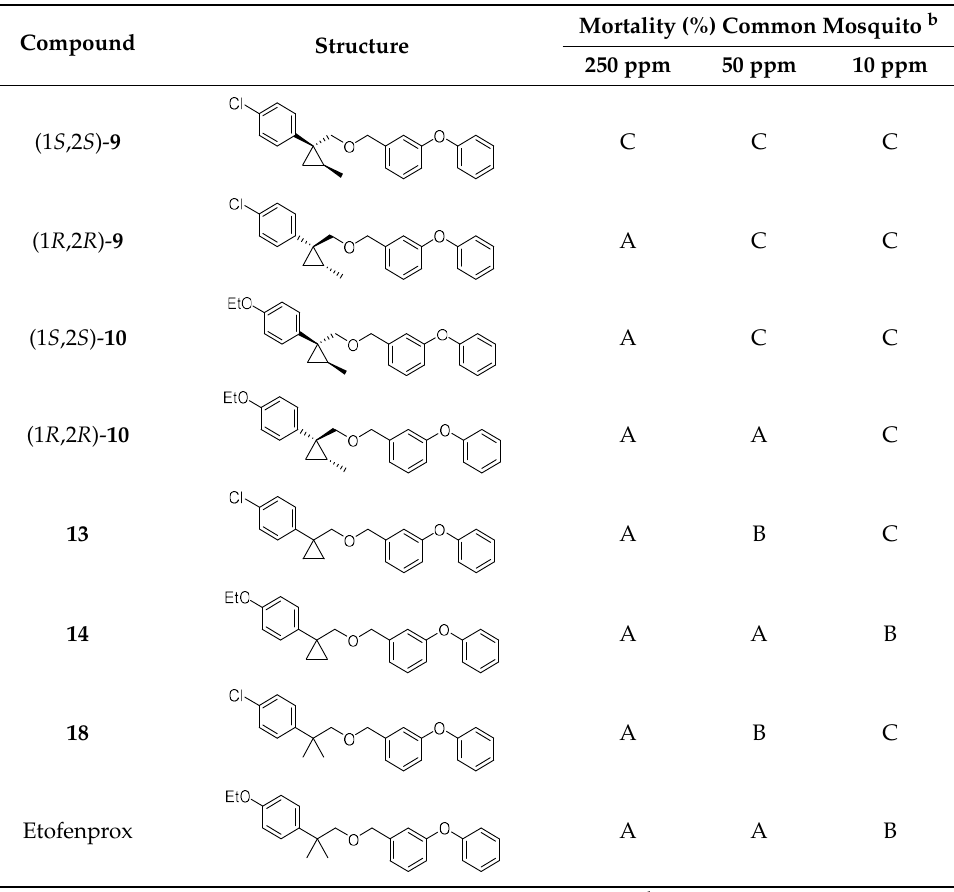
Table 3. Insecticidal activity of chiral ethers (1 S ,2 S )- 9 , (1 R ,2 R )- 9 and achiral reference compounds 13 , 14 , and 18 , and etofenprox. a Compound